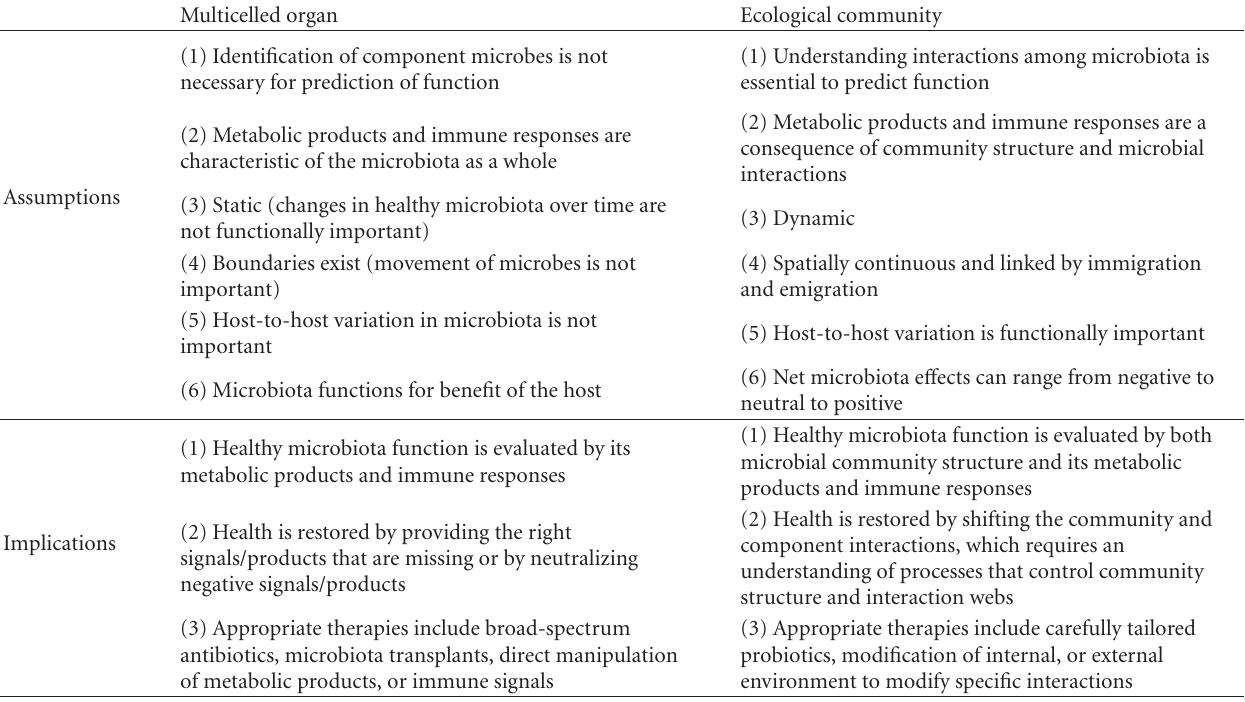
Table 1: Underlying assumptions of conceptualizing human microbiota as a multicelled organ versus an ecological community. Some of the assumptions of the multicelled organ conceptualization also apply to the intermediate conceptualizations depicted in Figure